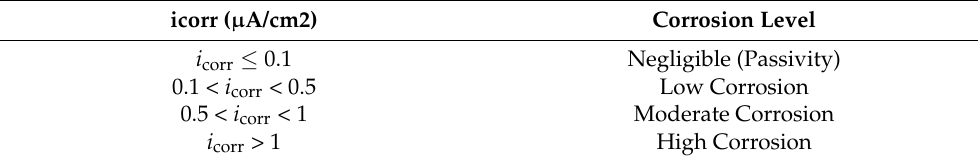
Table 9. Level of corrosion in accordance with the corrosion current density ( i corr ) [96].